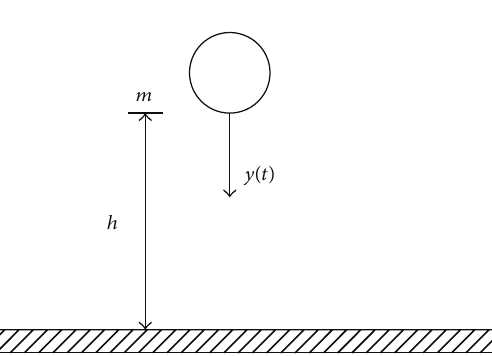
Figure 4: Numerical model of the